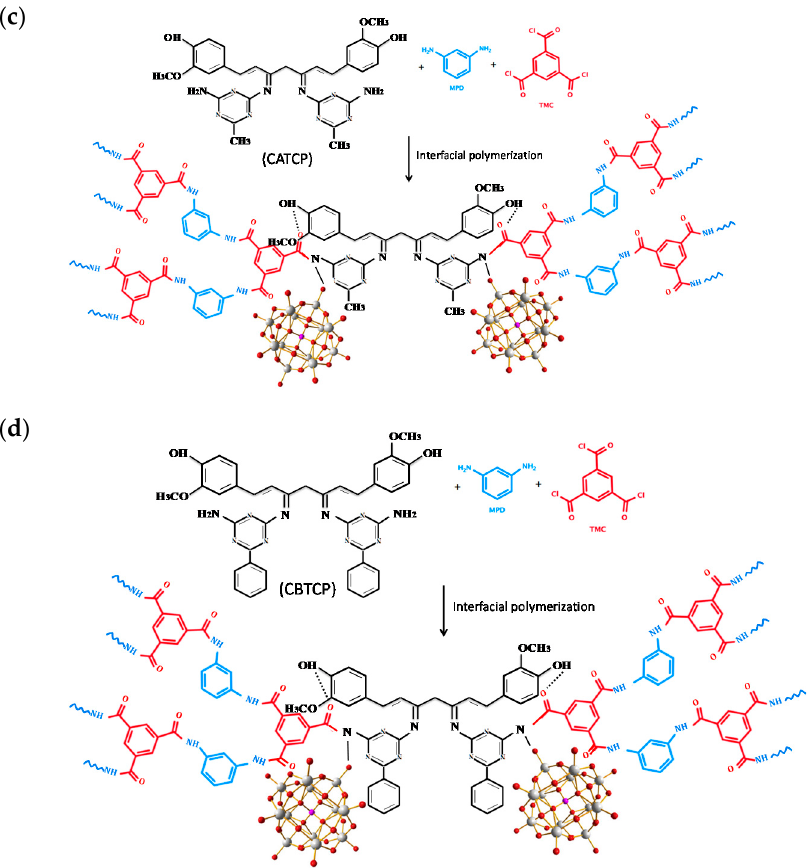
Figure 10. The proposed reactions between CPA, CPB, CATCP, and CBTCP during the interfacial polymerization of PA layer.